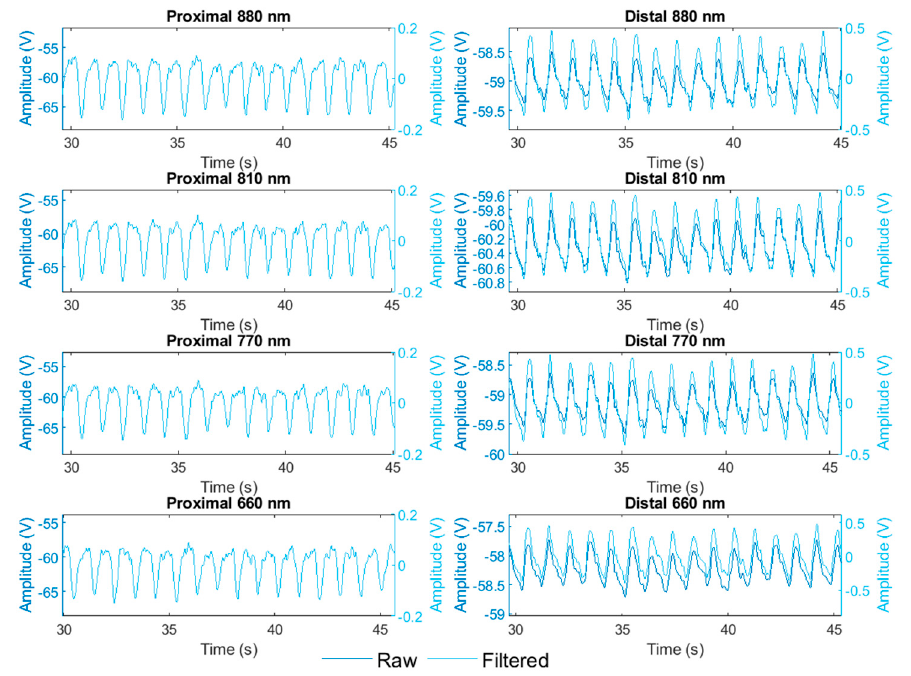
Figure 8. Raw and filtered PPG signals from two photodiodes using the head phantom at a normal ICP of 15 mmHg. Table 3. Signal quality indices comparison of the detectors and